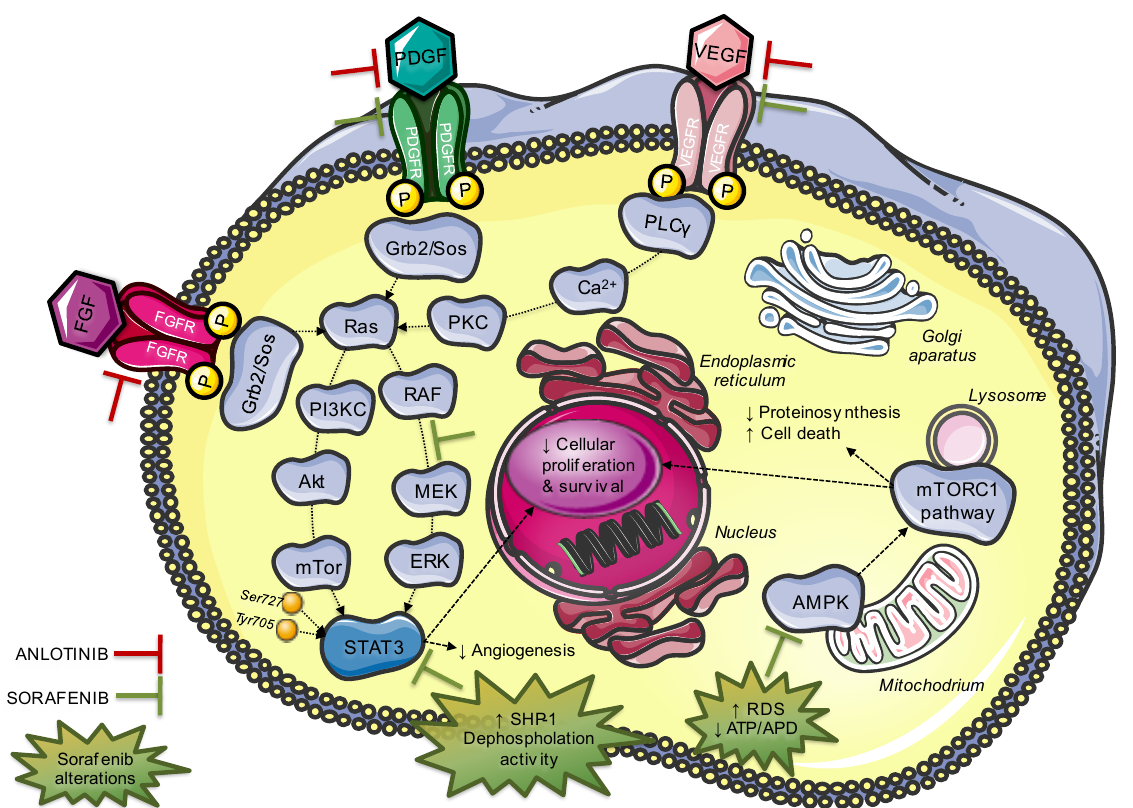
Figure 3. Genetic pathways and regulatory mechanisms modified by the administration of im- munotherapeutic agents.